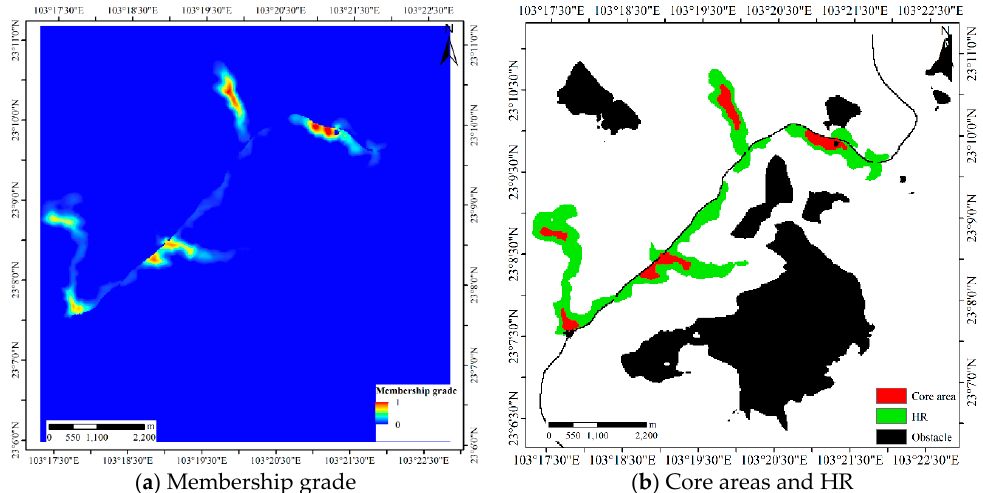
Figure 11. The membership grade, core areas and HR of Dataset 2.